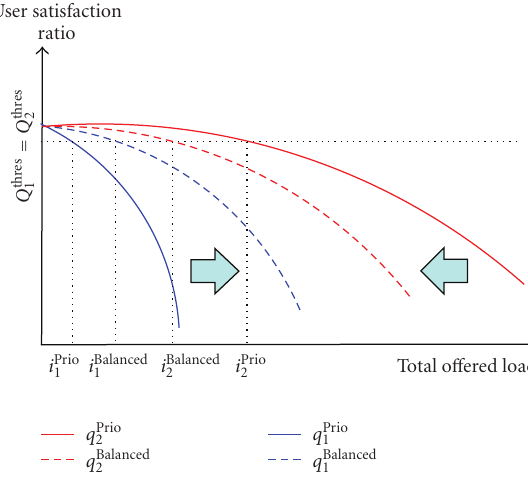
Figure 1: Illustration of the e ff ects of scheduling strategies in the joint system